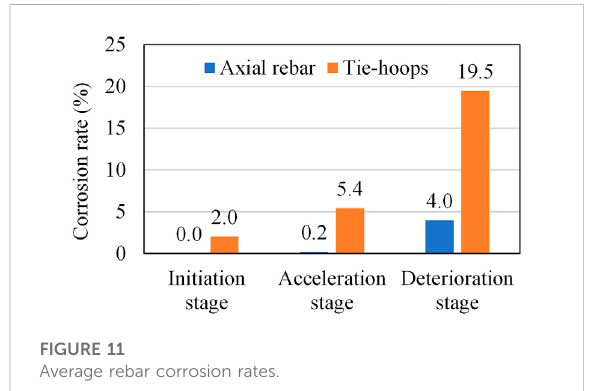
FIGURE 11 Average rebar corrosion